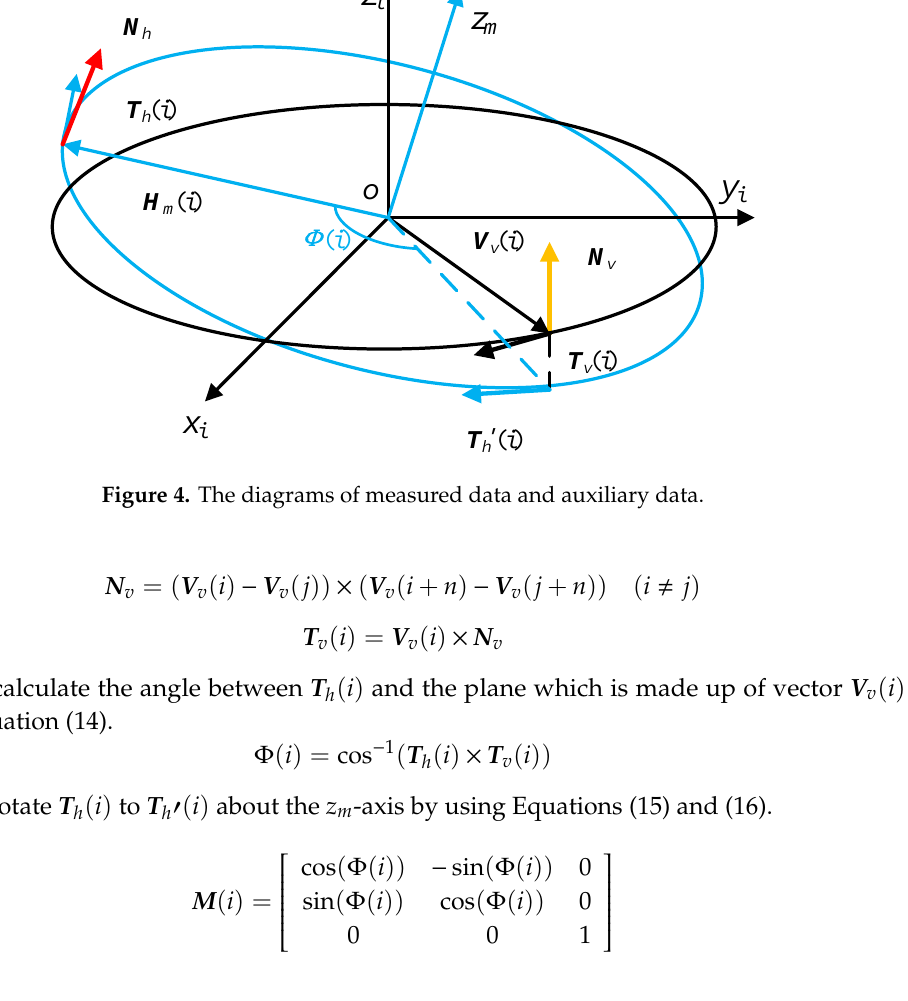
Figure 3. The diagram of measured data.